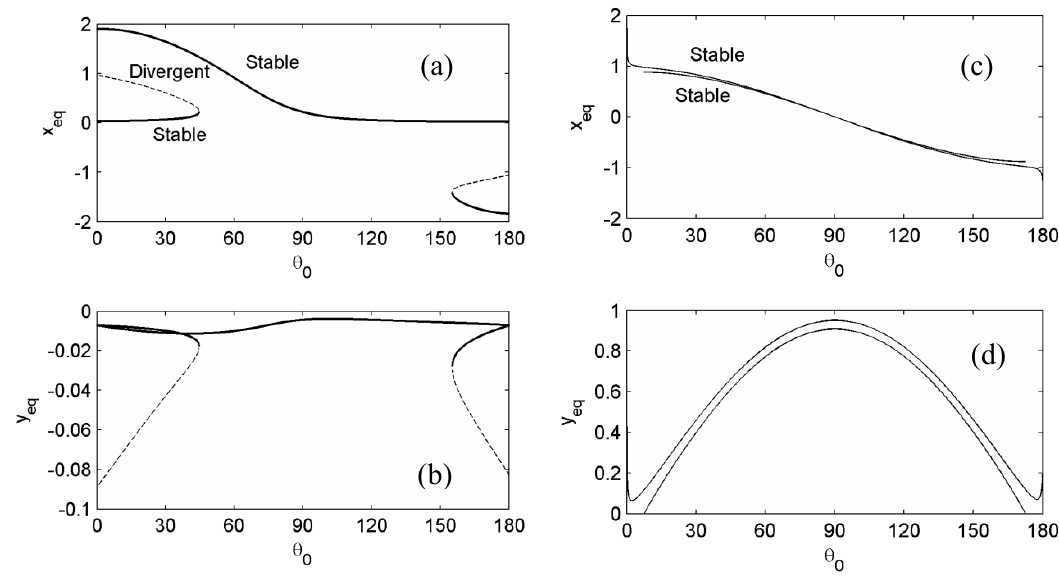
Figure 4. Equilibrium curves with respect to θ o at µ o = 0.5 for n (cid:44) 0 ( a ) x eq , ( b ) y eq and n = 0, ( c ) x eq ,